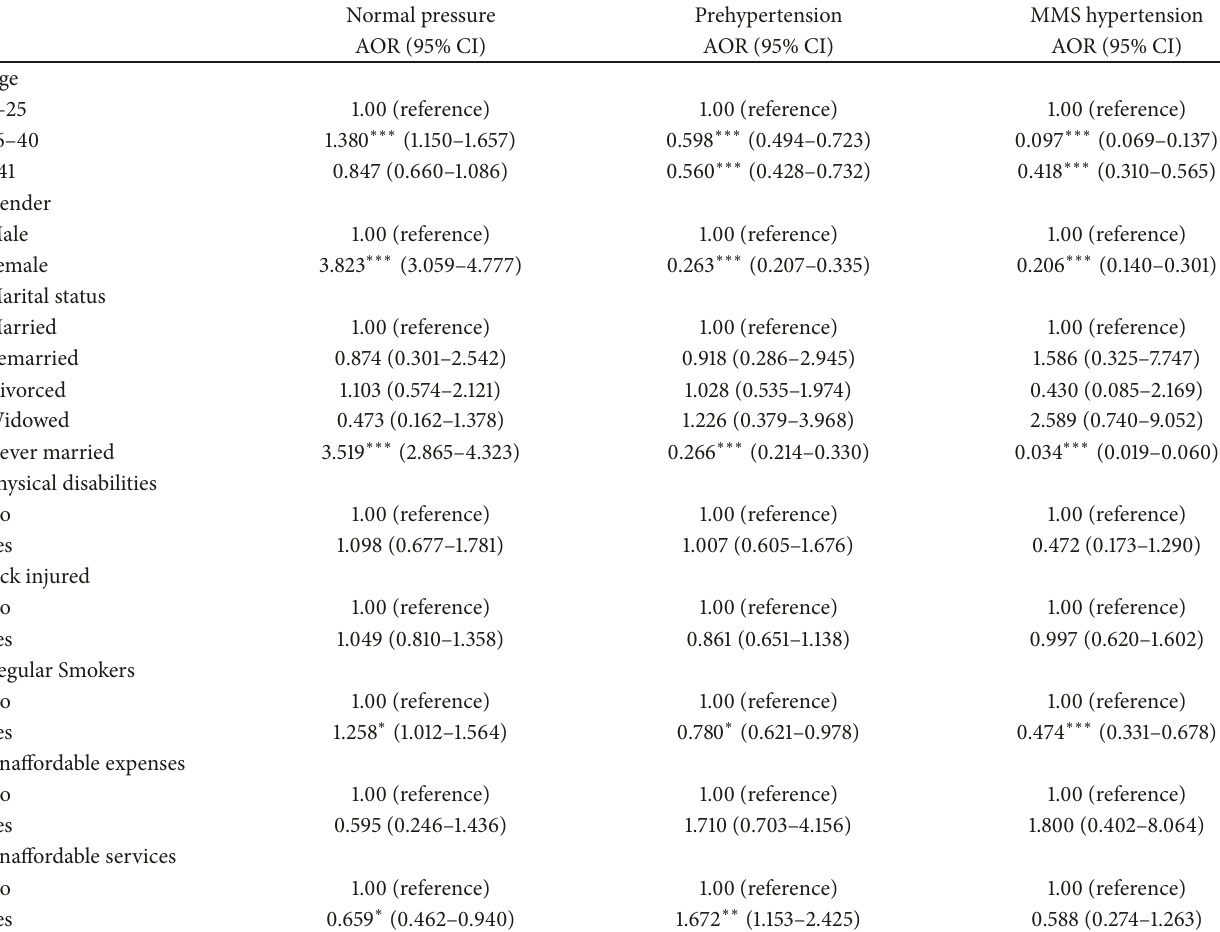
Table 4: Association between hypertensive states with economic